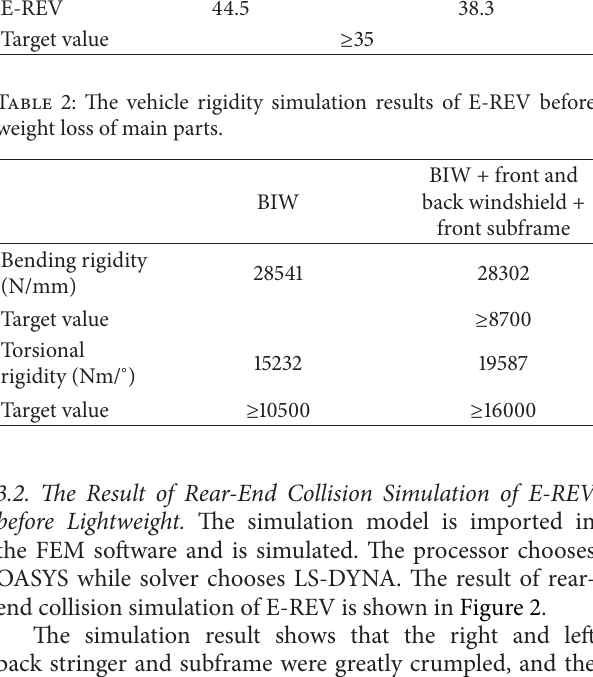
Table 1: The mode simulation results of E-REV before weight loss of main parts.